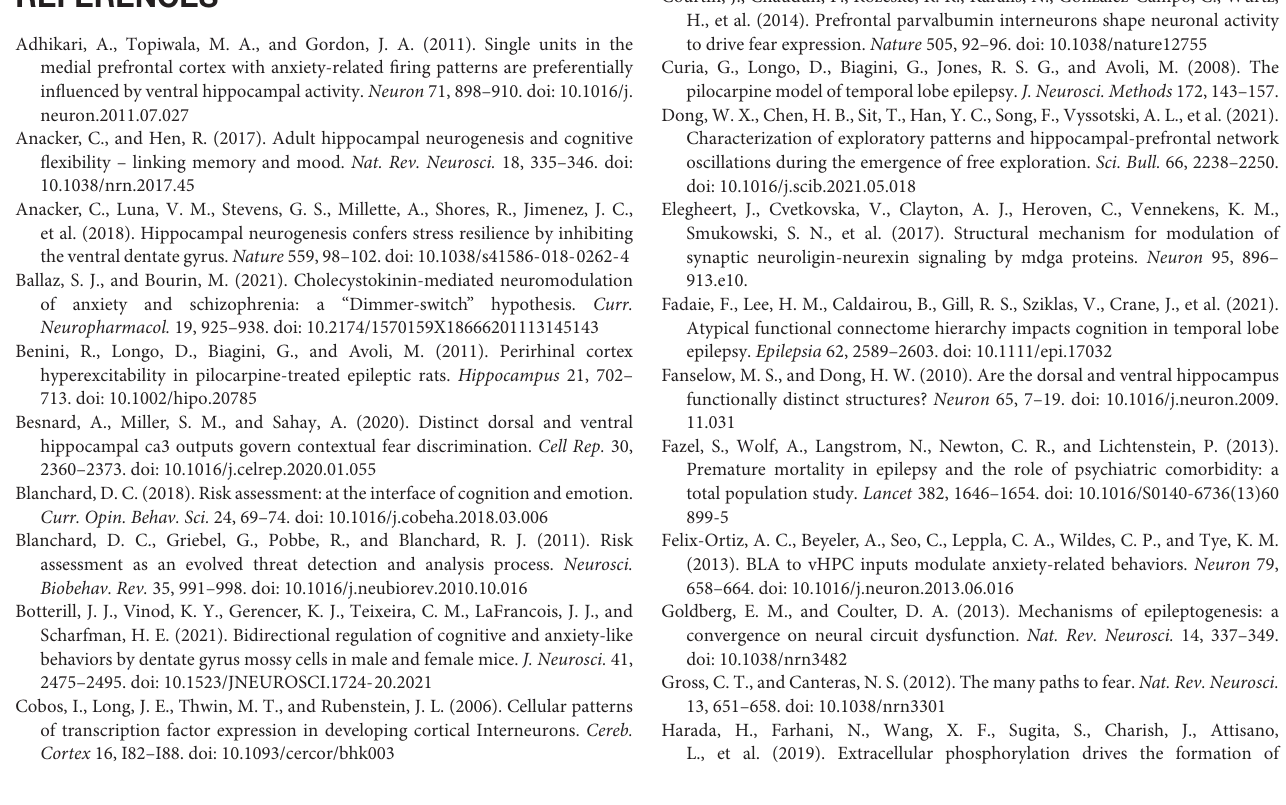
dDG/CA3 neurons responding negatively to RA, in which RA-inhibited neurons exhibited a phasic increase in the firing rate before RA (in close arm, duration, ∼ 2–3 s) and a subsequent decrease of the firing rate during RA (in center zone). Supplementary Figure 2 | The DAPI positive cells were reduced. The ratios were the fluorescence positive area (DAPI+ signal) divided area of ROI (region of interest) in dDG/CA3. WT, n = 22 slices from 6 mice, TLE, n = 27 slices from 6 mice. Error bars represent s.d. ∗∗∗ p < 0.001. Two-sample t -test. Supplementary Figure 3 | Overview of RNA sequencing flow diagram. Wild-type 6-week-old C57BL/6J male mice were obtained and housed for 2-week environmental acclimation. Half of the wild-type 8-week-old mice were subjected to KA-injection. All mice were housed to 20-week-old for sampling. Supplementary Figure 4 | Comparison of BrdU+ neurons in WT vs. TLE. (A) Representative images of immunostaining of BrdU+ neurons in dDG of WT and TLE mice. Scale bar, 50 µ m. (B) The number of BrdU+ neurons in dDG (BrdU+: WT, n = 14 slices from 2 mice, TLE, n = 8 slices from 3 mice) (Error bars represent s.d; ∗∗ p < 0.01, two-sample t test). Supplementary Figure 5 | Morphological changes in PV+ neurons. Representative confocal images at 40 × showed that the morphology of PV+ neurons cell body altered in dDG/CA3 of TLE mice. Scale bar, 20 µ m. Supplementary Figure 6 | Chemogenetics inhibition of hippocampal SOM+ neurons or optogenetic activation of hippocampal glutamatergic neurons impaired the RA. (A–D) Chemogenetics inhibition of hippocampal SOM+ neurons. (A) The approach-RA duration. (B) The approach-RA entries. (C) The avoid-RA duration. (D) The avoid-RA entries (before CNO, n = 9; CNO administration, n = 9). (E–H) Optogenetic activation of hippocampal glutamatergic neurons. (E) The approach-RA duration. (F) The approach-RA entries. (G) The avoid-RA duration. (H) The avoid-RA entries (before light, n = 12; light on, n = 12) (ns is no significant difference; error bars represent s.d; ∗ p < 0.05; ∗∗∗ p < 0.001, paired- t